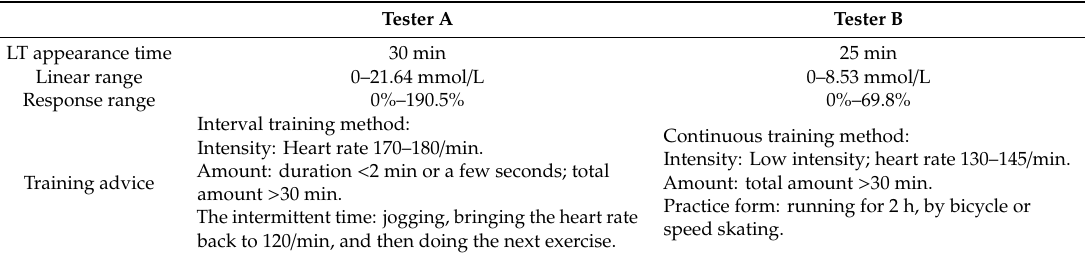
Table 1. Testers’ physiological status and training recommendations. LT, lactate